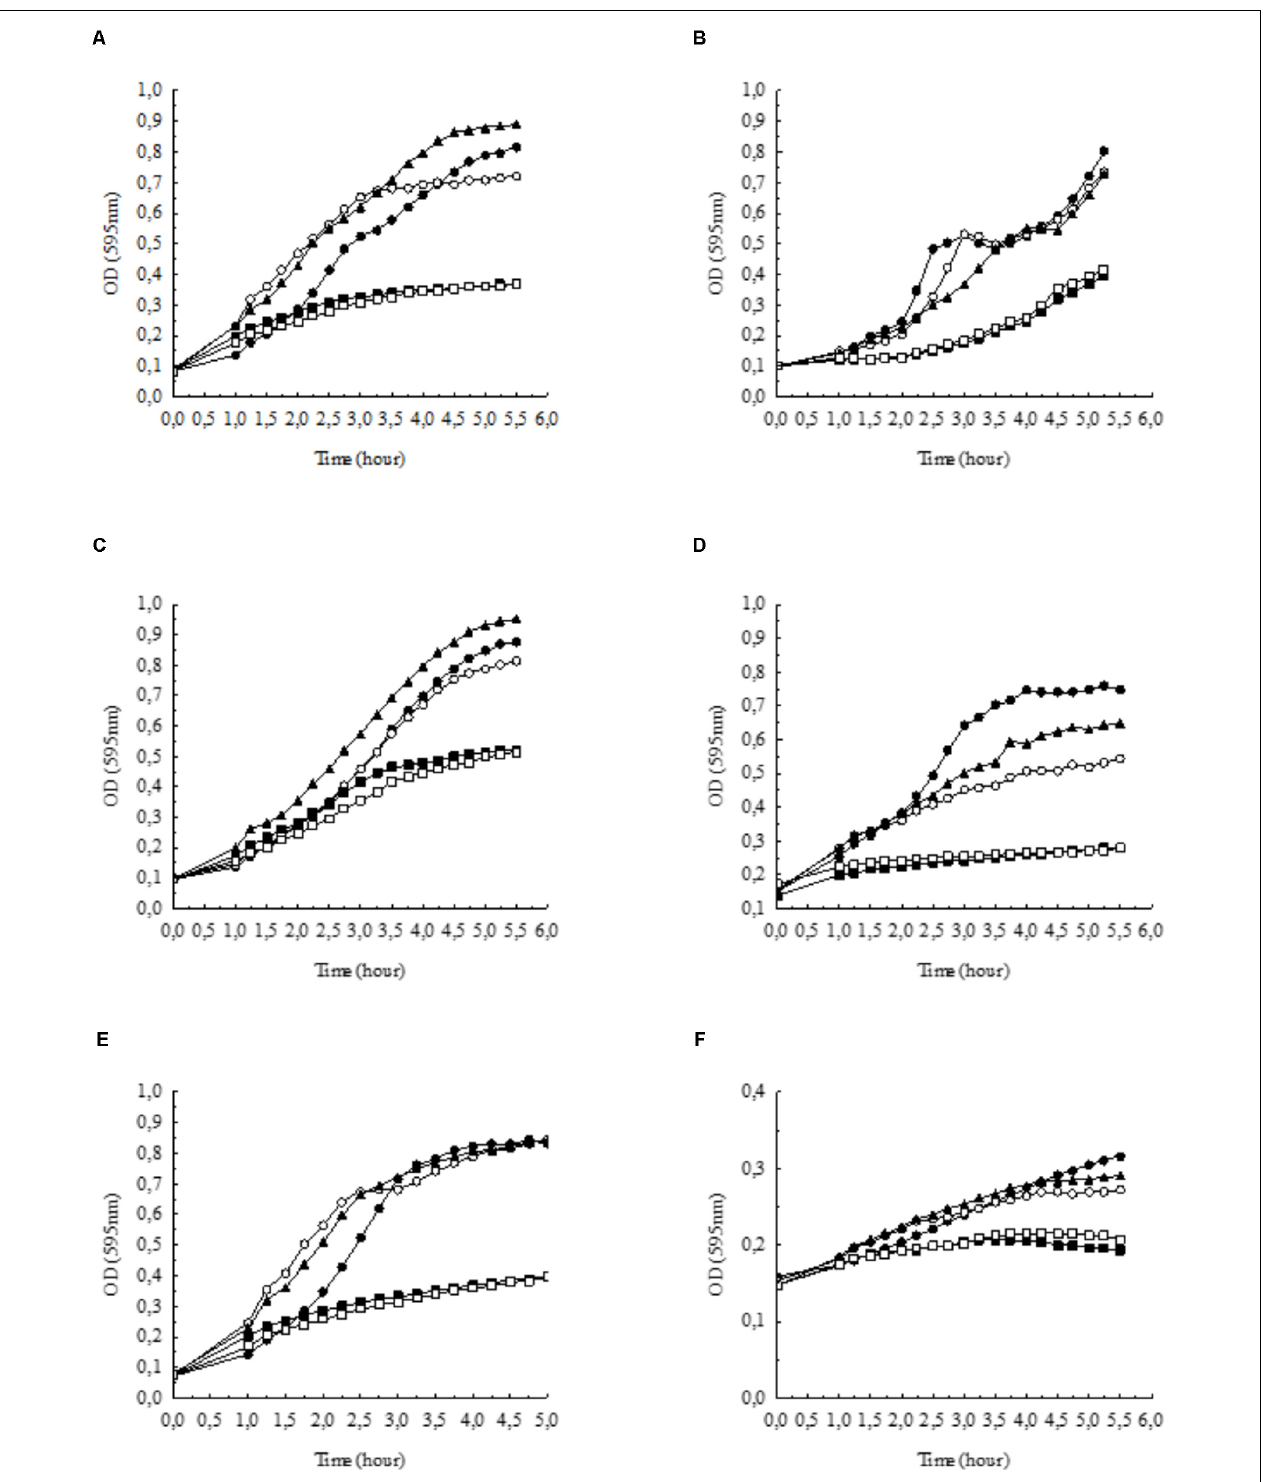
FIGURE 1 | Growth of (A) Escherichia coli , (B) Pseudomonas aeruginosa , (C) Staphylococcus aureus , (D) Streptococcus agalactiae , (E) Enterococcus faecalis , and (F) Haemophilus influenzae in BHI broth supplemented with NaHCO 3 compared to control conditions ( • : control pH = 7.4, (cid:78) : 100 mmol l − 1 NaCl, pH = 7.4). Bicarbonate-containing solutions were equilibrated with either 5% ( (cid:3) : 100 mmol l − 1 NaHCO 3 , pH = 8.5) or 20% CO 2 ( (cid:4) : 100 mmol l − 1 NaHCO 3 , pH = 7.4). In the absence of bicarbonate, pH was adjusted to 8.5 with NaOH ( ◦ : growth at pH = 8.5). Each curve shows the average of two parallel experiments. Standard Deviations were generally less than 1% of the mean and are not shown. Note that in panel (F) the scale on the y axis differs from the other panels.